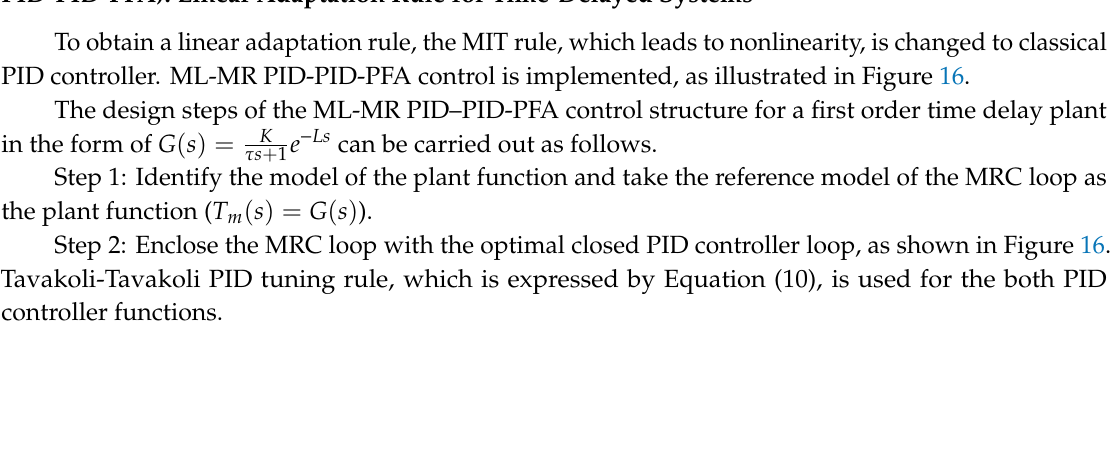
Figure 16. Block diagram of ML-MR PID-PID-PFA control structure.